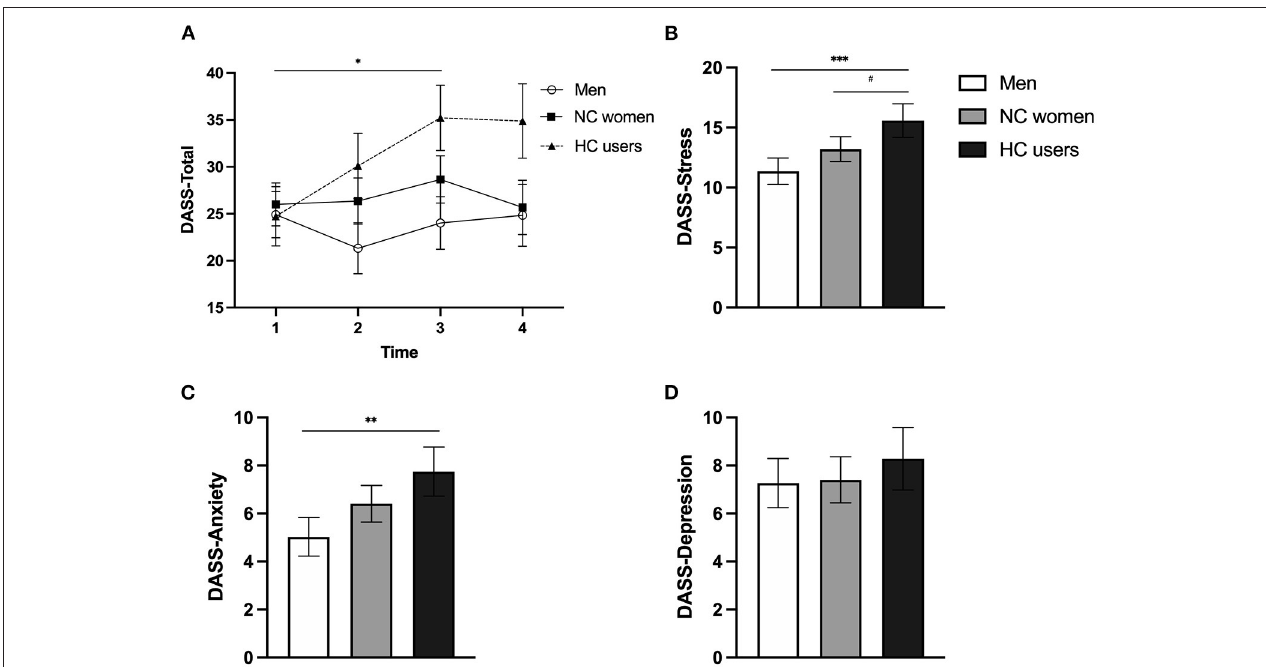
FIGURE 3 | Symptoms of depression, anxiety, and stress (measured by the DASS-21 scores) of men, naturally cycling (NC) women, and women using hormonal contraceptives (HC) during the COVID-19 pandemic. (A) General distress evolution during the pandemic. Men, NC women, and HC users are illustrated by circles, squares, and triangles, respectively. (B) Mean stress symptoms. (C) Mean anxiety symptoms. (D) Mean depressive symptoms. Men, NC women, and HC users are illustrated by white, gray, and black bars, respectively. Error bars represent standard error. # < 0.08, * p < 0.05, ** p < 0.01, *** p <